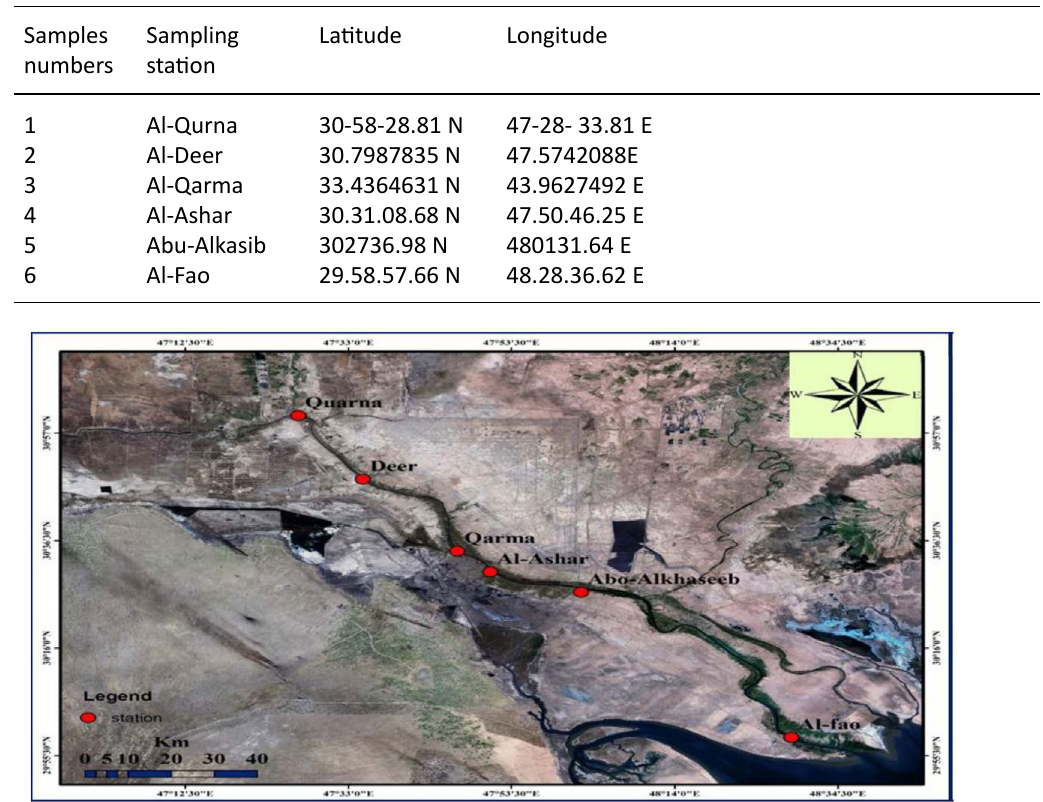
Table 1. The name and the coordination of studied stations